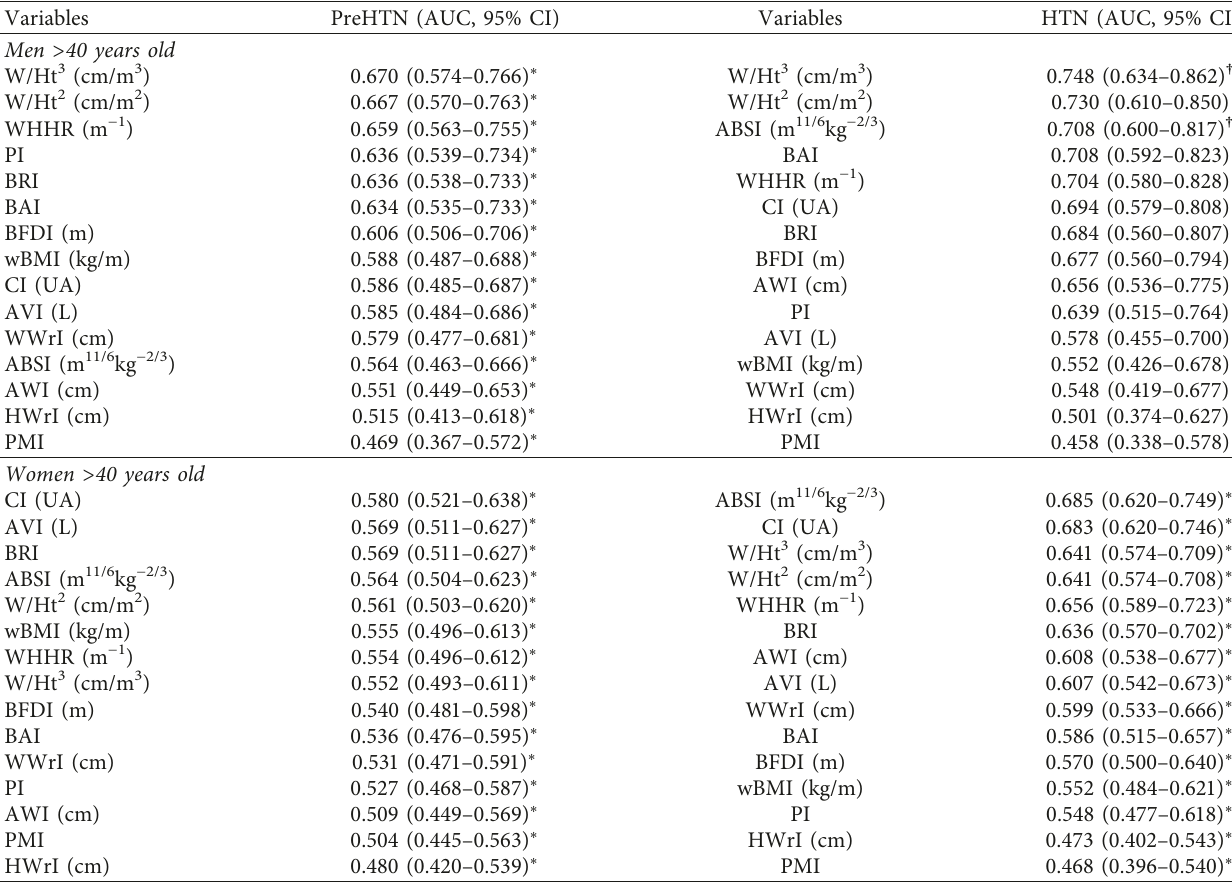
Table 5: Predictive value of the emergent anthropometric indices for preHTN and HTN by gender in > 40 years old.